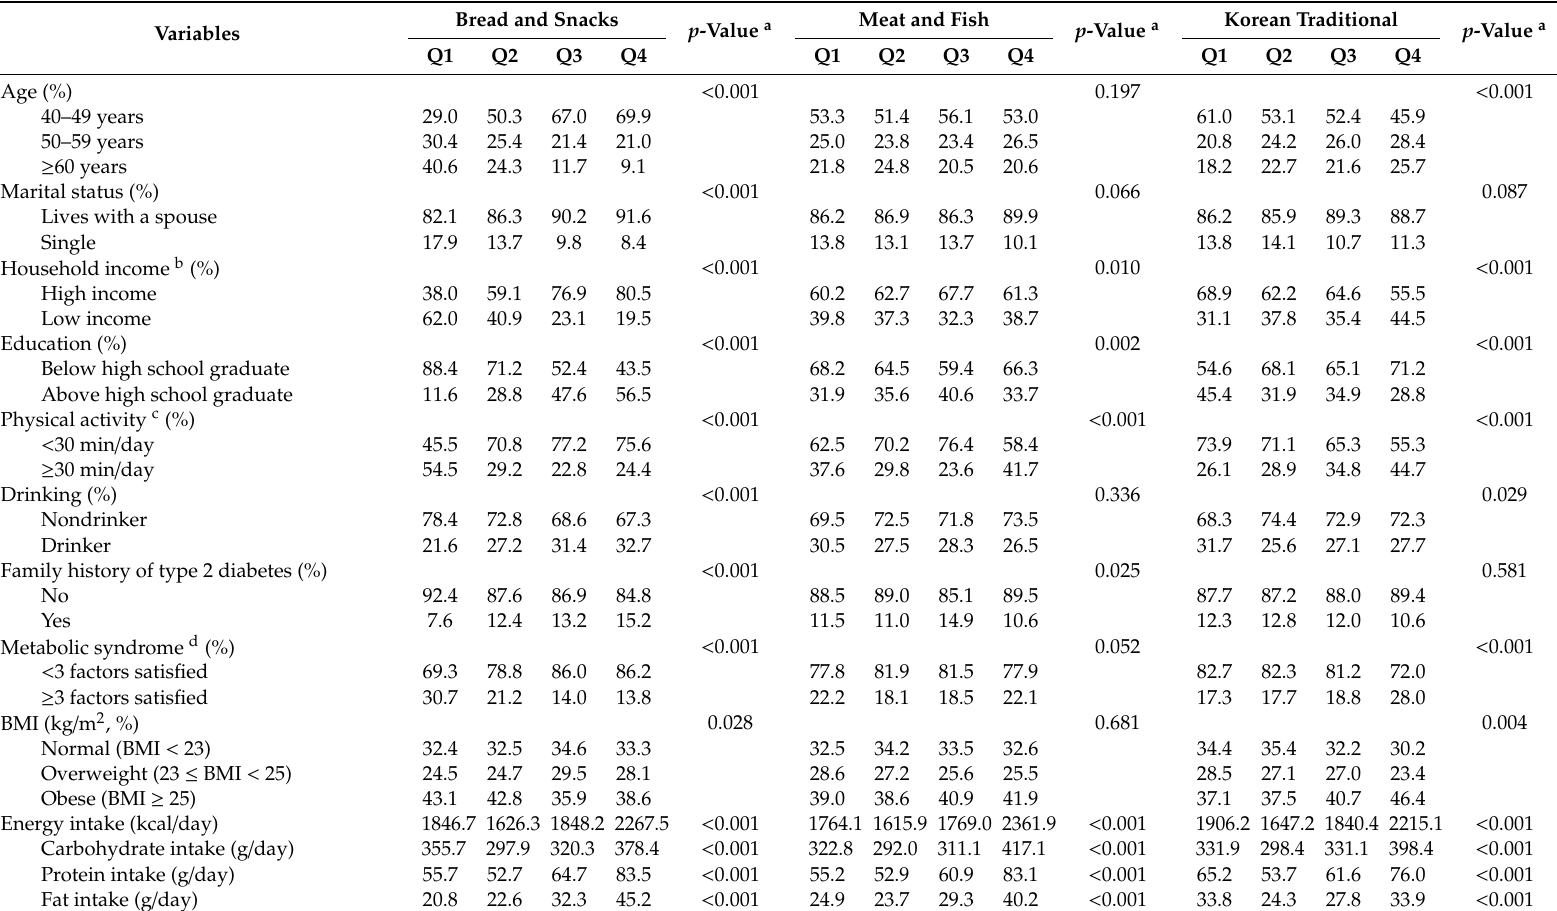
Table 2. Baseline characteristics of female subjects according to dietary